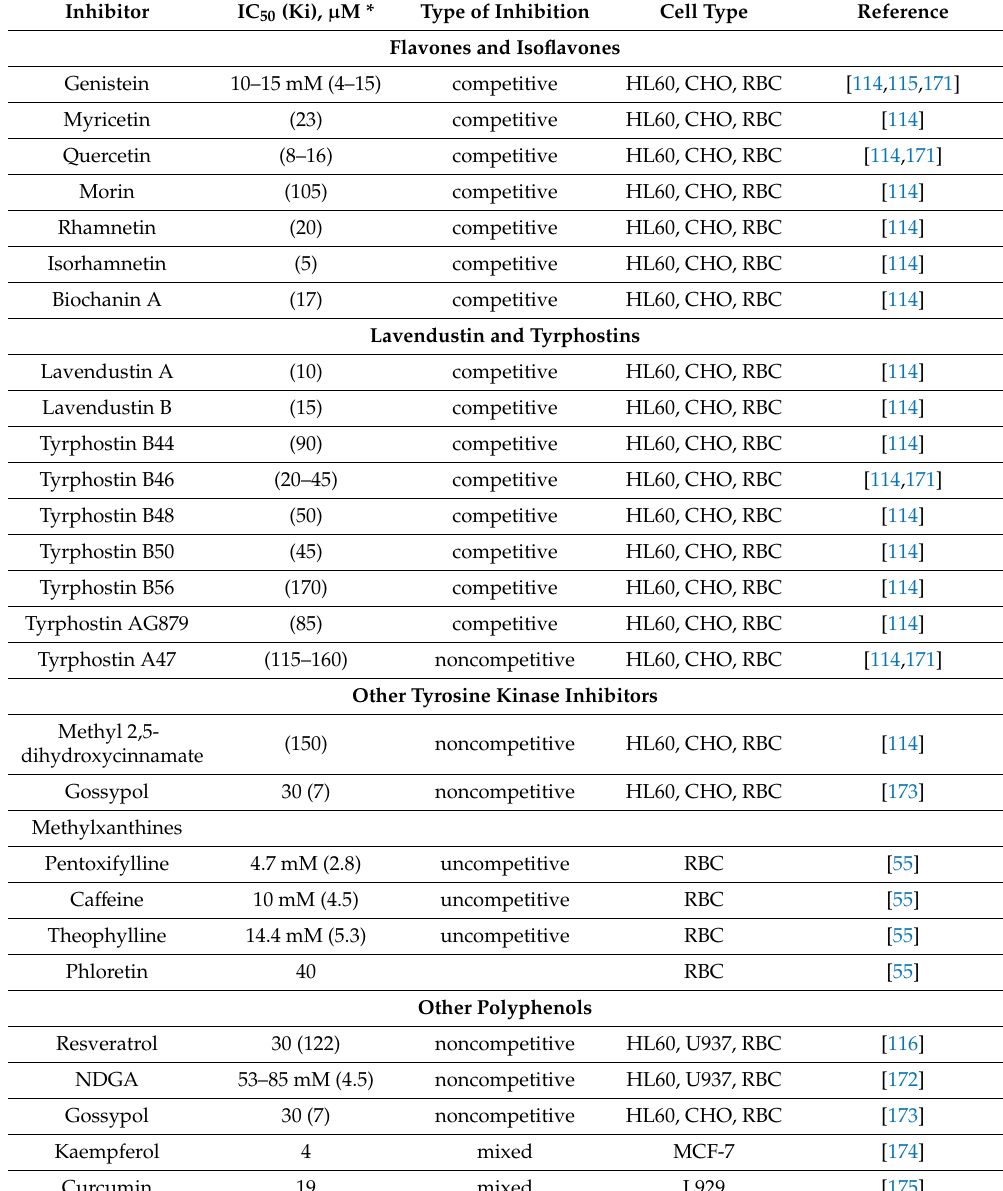
Table 3. Molecule inhibitors of